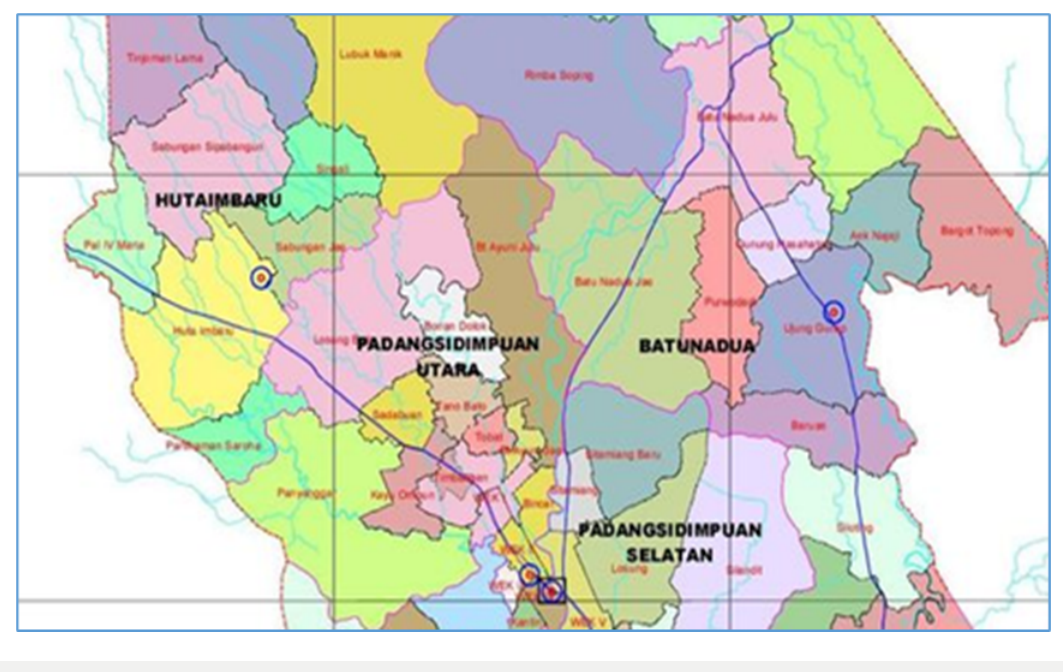
Figure 1 Map of the study